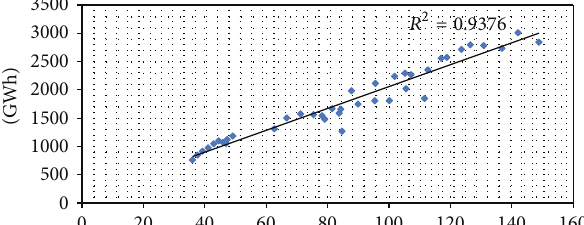
Figure 2: Energy delivered versus the number of